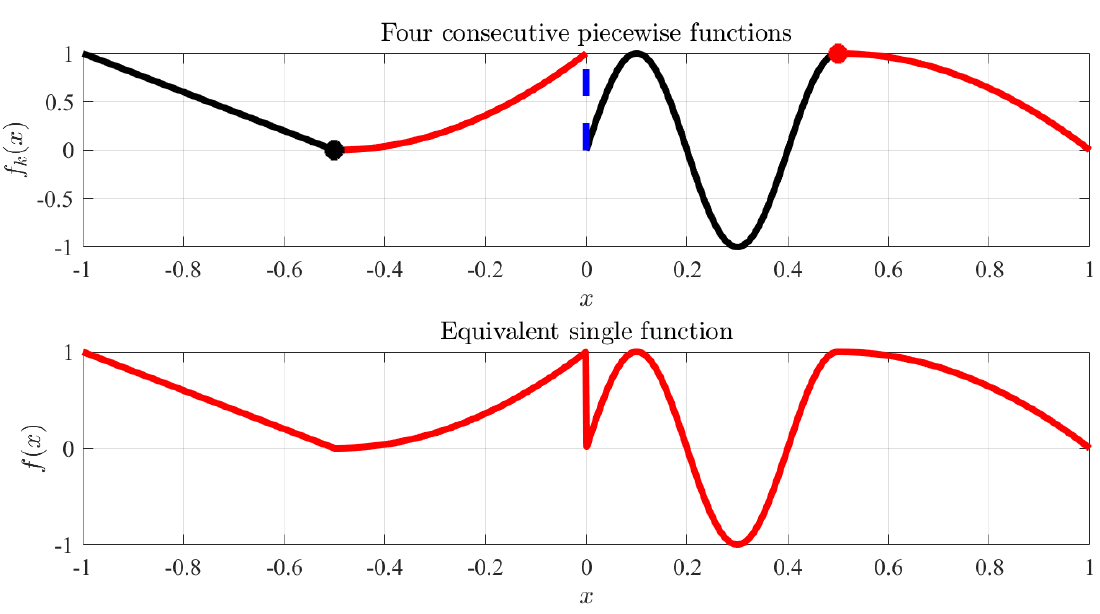
Figure 5. Four functions given in Equation (8) ( top ) and equivalent single function given by Equation (9) ( bottom